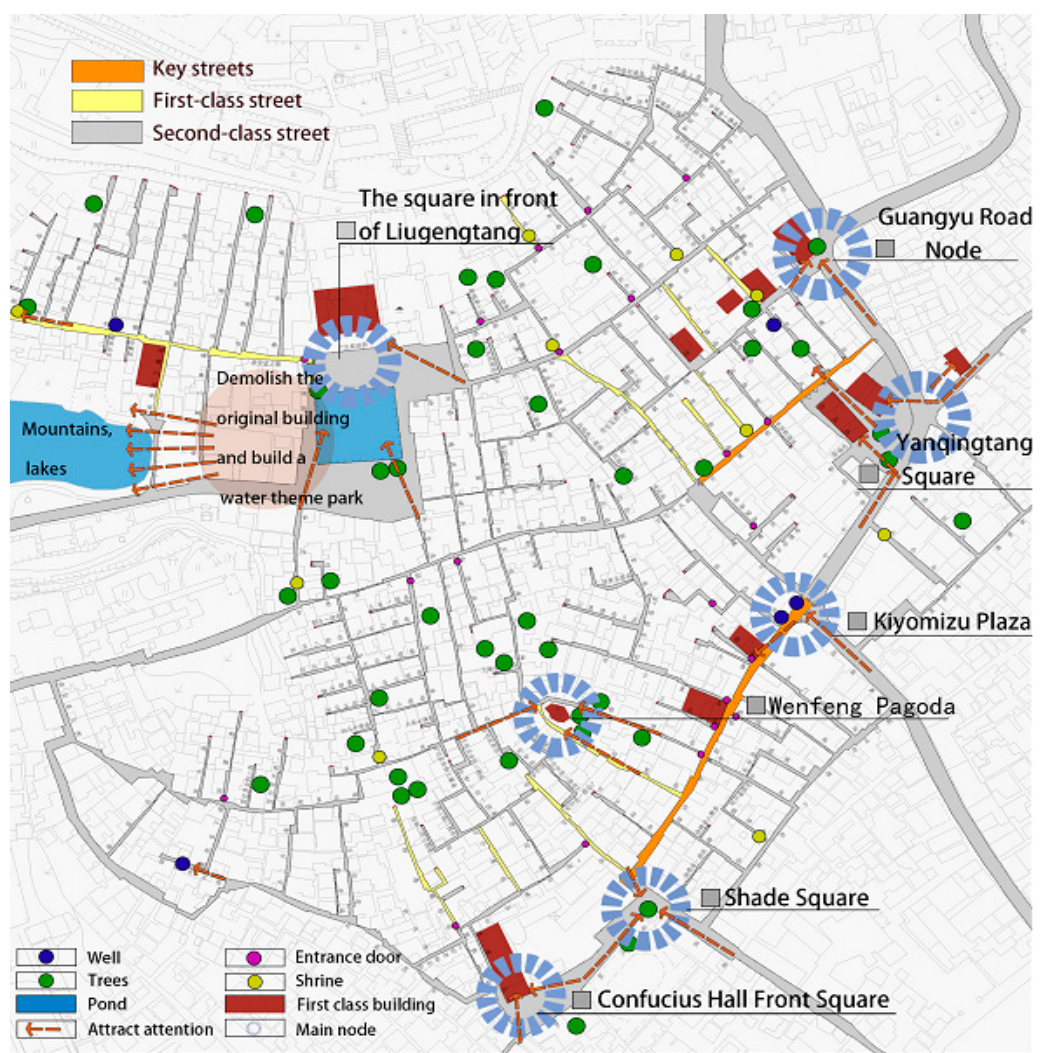
Figure 8. Key transformation node diagram. (Source: the authors).